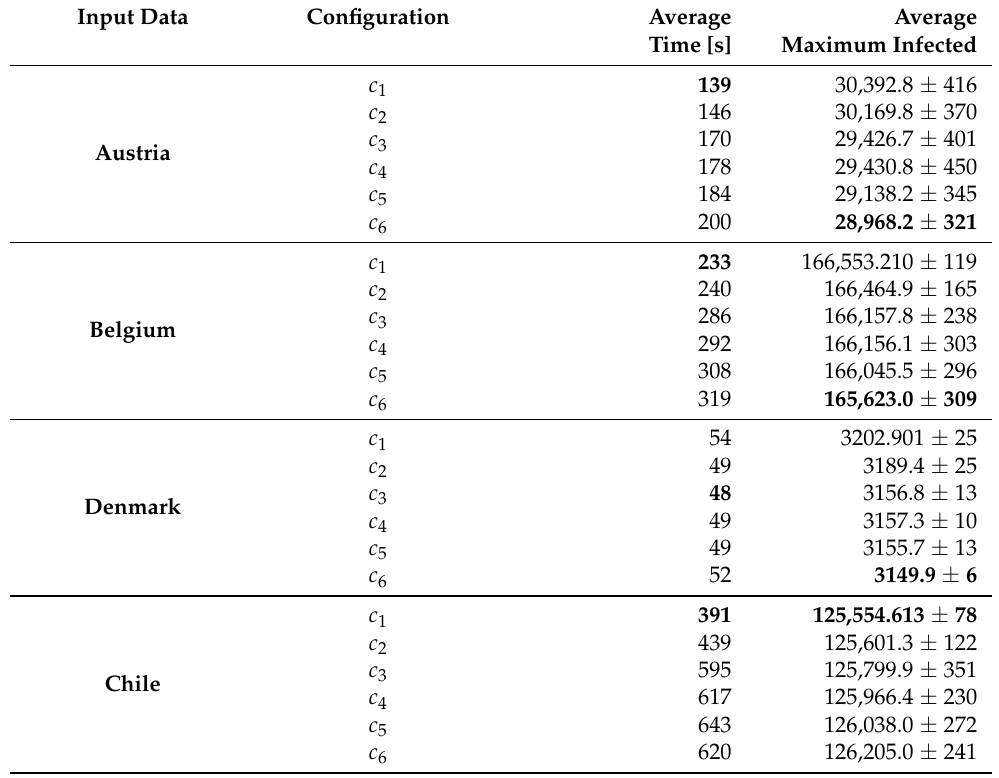
Table 2. Average time and maximum infected population obtained per country file for different probabilities of the movements. The best value per file is highlighted in bold. Input Data Configuration Average Average Time